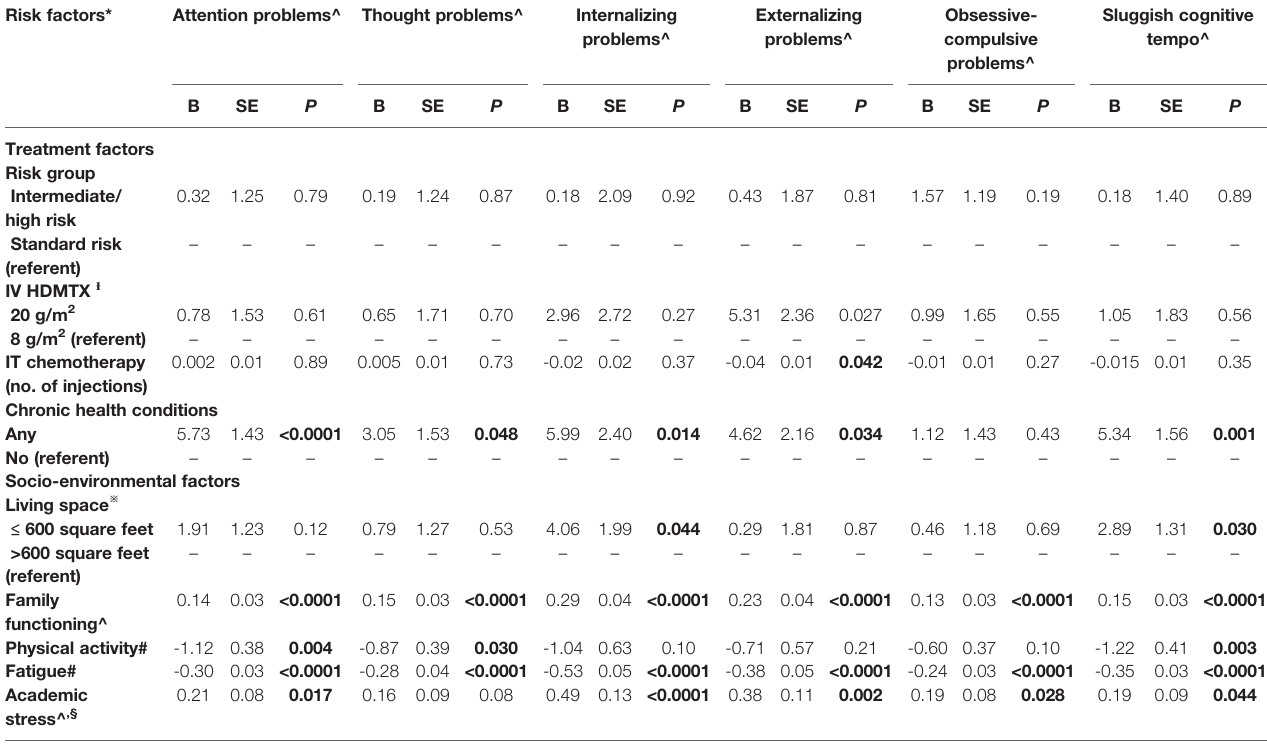
TABLE 3 | Factors Associated with Behavioral Outcomes.